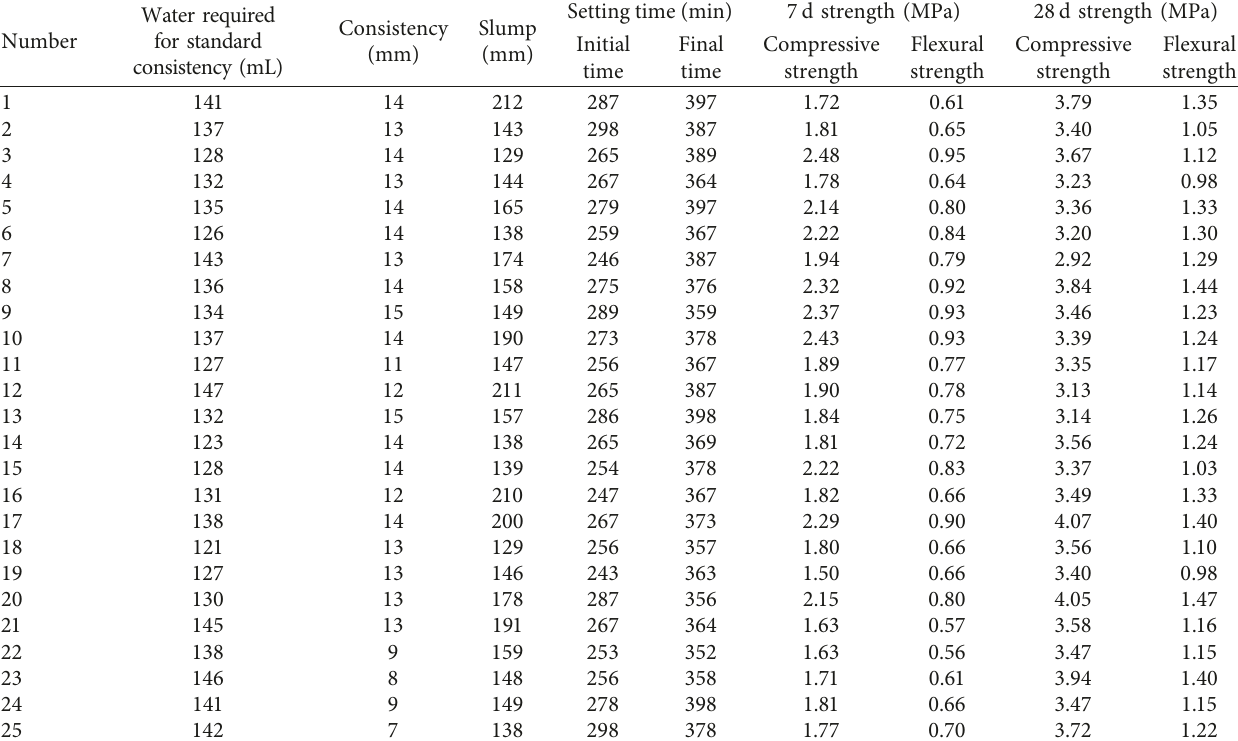
Table 4: Results of the orthogonal